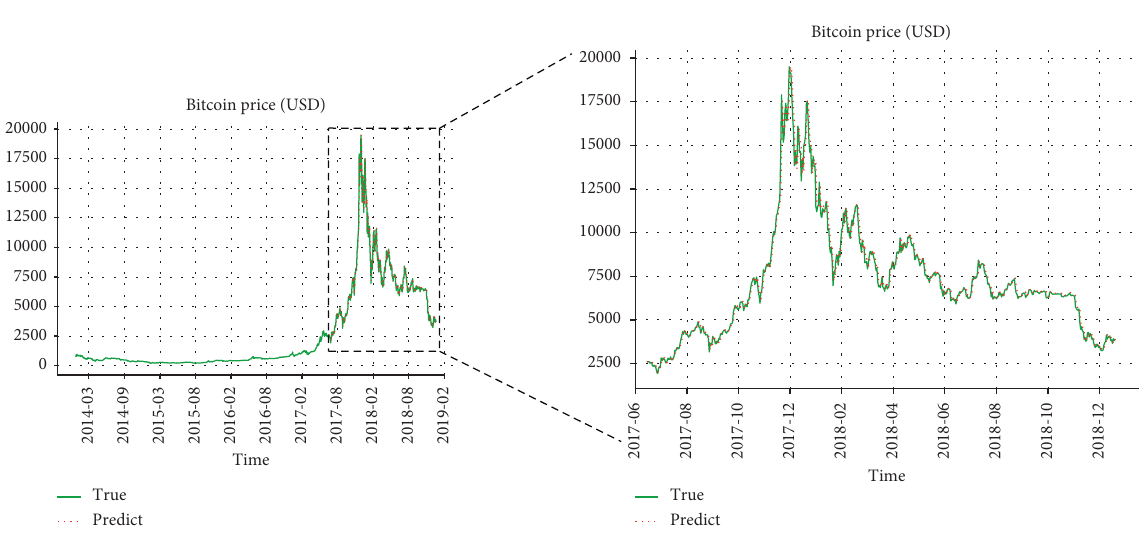
Figure 3: The bitcoin price prediction with consideration of the S&P index.